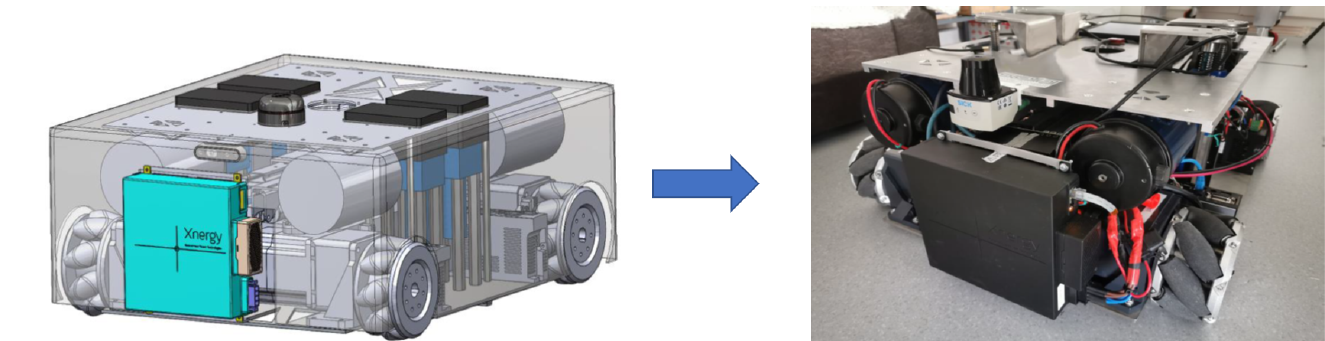
Figure 1. Design of WASP